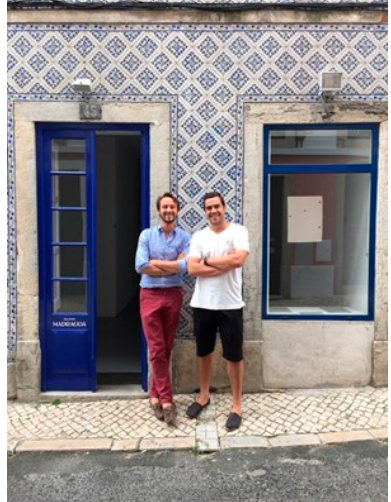
Figure 4. Madragoa, Matteo Consonni and Gonçalo Jesus, 2016. © Madragoa.